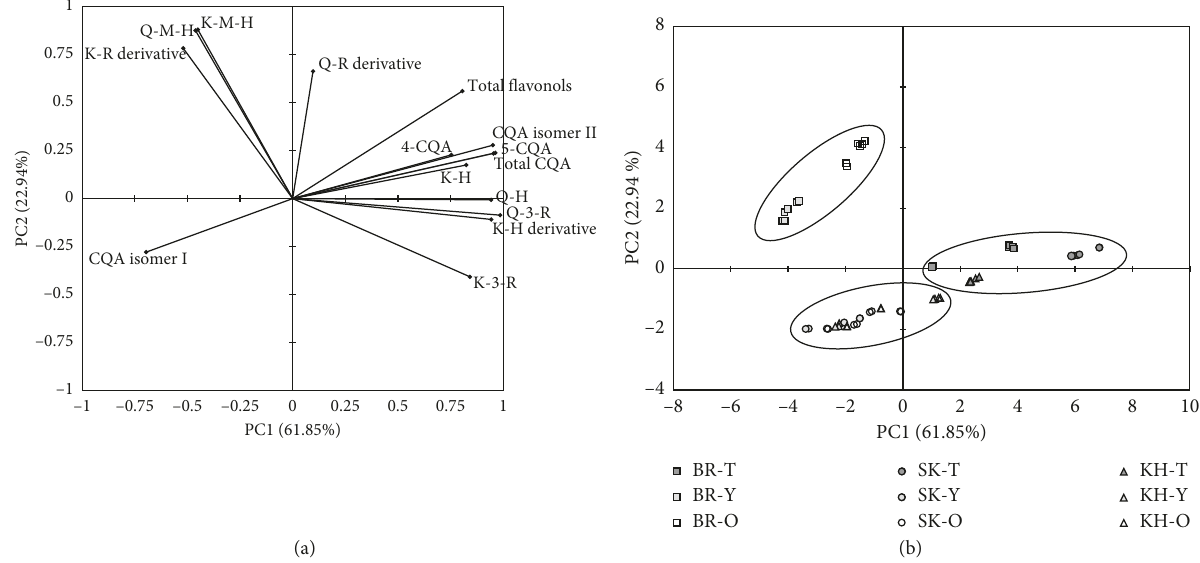
Figure 2: Principal component analysis based on phenolic compounds of different 9 samples of mulberry leaves: (a) scattering plot of loadings on principle components PC 1 and PC 2; (b) sample map of scores on PC1 and PC 2 as function of cultivars and leaf age. 4-CQA: 4- O -caffeoylquinic acid; 5-CQA: 5- O -caffeoylquinic acid; CQA isomers I, II: caffeoylquinic acid isomers I, II; total CQA: total caffeoylquinic acids; K-H: kaempferol-hexoside; Q-H: quercetin-hexoside; Q-3-R: quercetin-3- O -rutinoside; K-3-R: kaempferol-3- O -rutinoside; K-M-H: